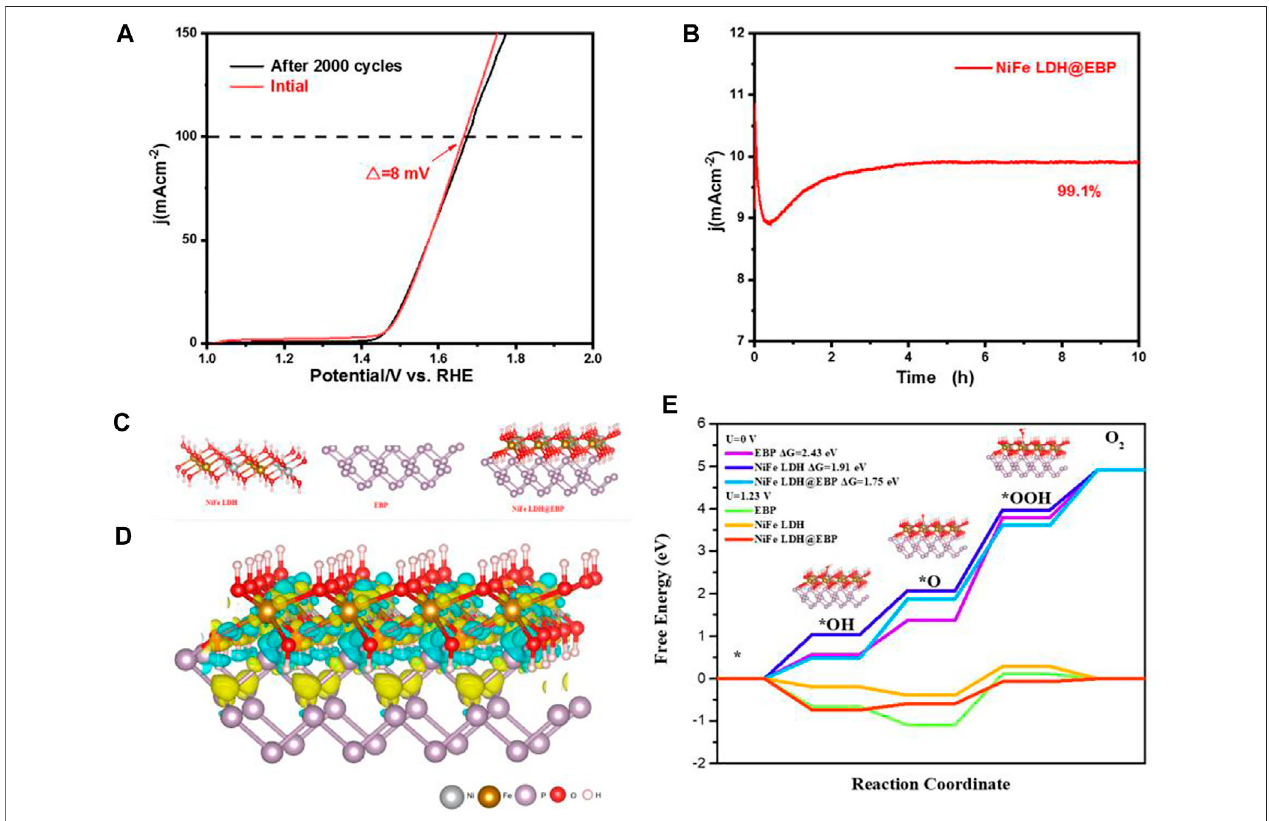
FIGURE7|(A) LSVcurvesforNiFeLDH@EBPbeforeandafter thetestof2,000CVcycles, (B) chronoamperometrycurvesofNiFeLDH@EBPatacurrentdensity of10 mA cm − 2 , (C) optimizedcon fi gurationsofBPandNiFe-LDHheterointerfacesthroughP-Obonding,and (D) differentialchargedensityofNiFeLDH@BP.Theyellow and green contours represent the charge accumulation and depletion, respectively. The isosurface plotted is 0.003 eV/Å − 1 , and (E) energy pro fi les of the OER steps on BP, NiFe, LDH, and NiFe LDH@BP surfaces.